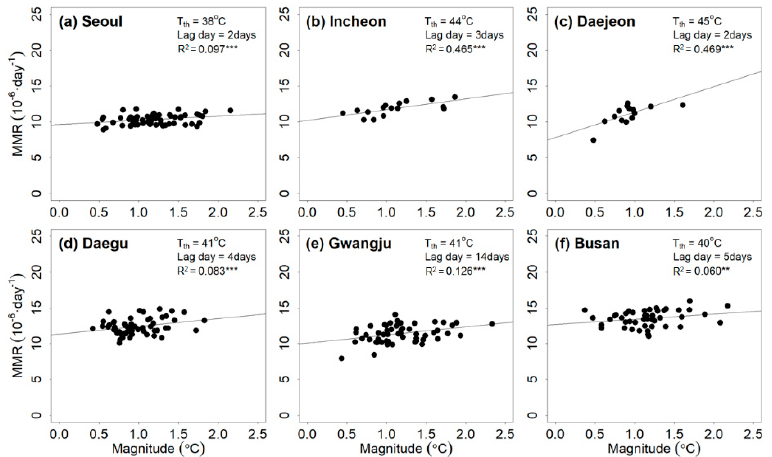
Figure 2. Relationship between the magnitude of the heatwave event based on maximum perceived temperature (PTmax) and mean total mortality rate (MMR) for ( a ) Seoul, ( b ) Incheon, ( c ) Daejeon, ( d ) Daegu, ( e ) Gwangju, and ( f ) Busan during the training period (2000–2016). Note that *** and ** indicate that the R 2 estimates are significant at the 95% and 90% levels, respectively; NS indicates that the R 2 estimate is insignificant based on the 85% significance level.